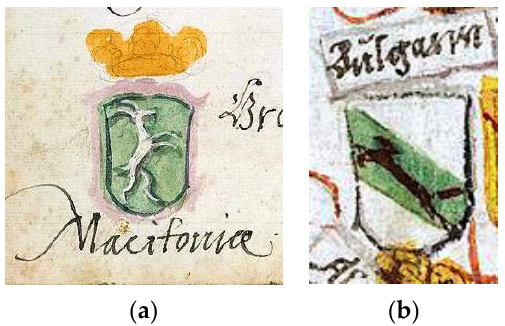
Figure 18. Coats of arms of ( a ) Macedonia ( b ) Bulgaria from the Koloriertes Wappenbuch .